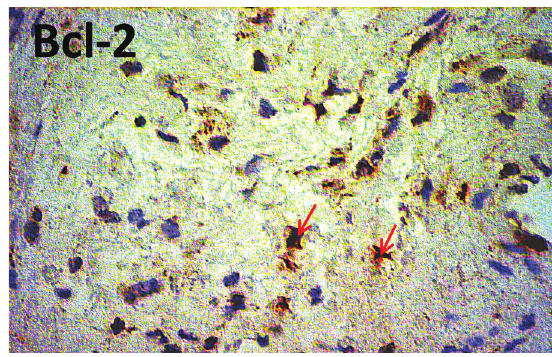
Figure 1 - Immunostaining for Bcl-2 in the nasal mucosa of a control individual. Brown staining shows Bcl-2 expression (red arrows). Some Bcl-2 positive cells are found in the lamina propria. 400x.